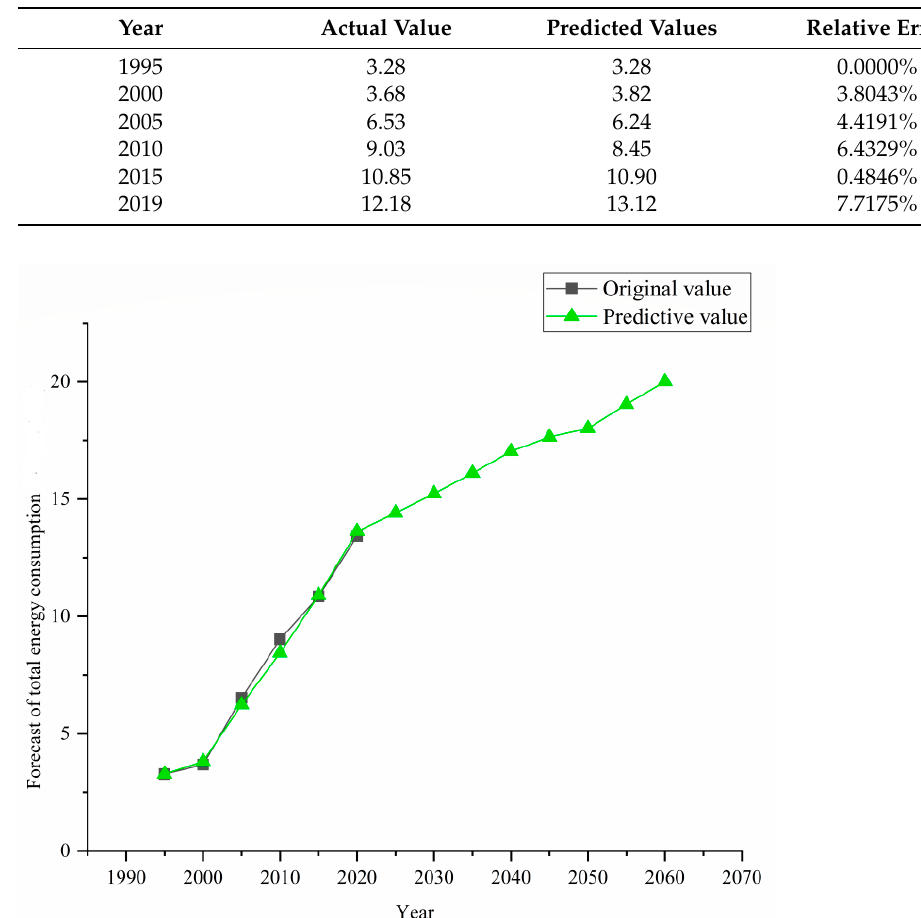
Figure 6. Forecast of total energy consumption (billion tce).